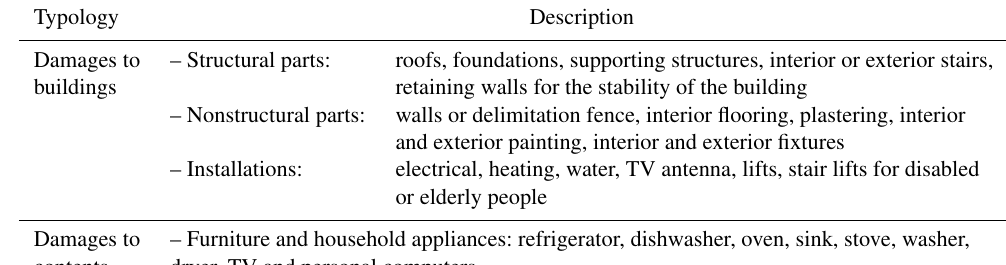
Table 2. Refundable assets in accordance with ordinance no. 2 of 5 June 2014 and law no. 93 of 26 June 2014.